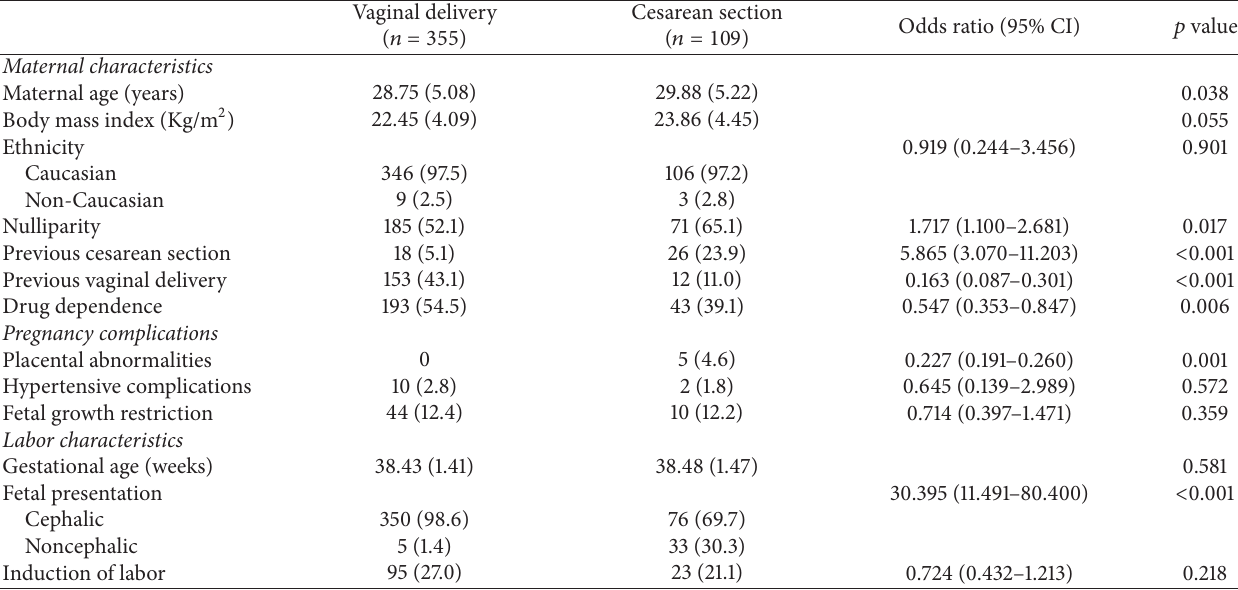
Table 2: Factors that influenced the mode of delivery in the study